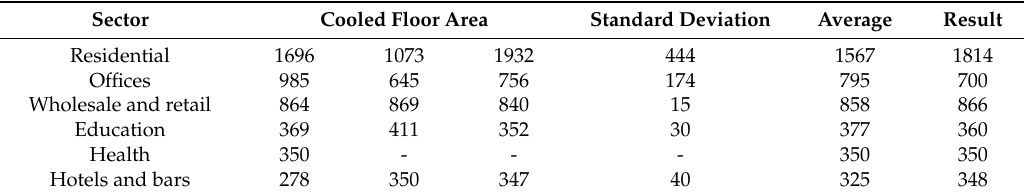
Table A1. Statistical calculations regarding the cooled floor area per sector, EU15, (Mm 2 ) [15–17,20–25,